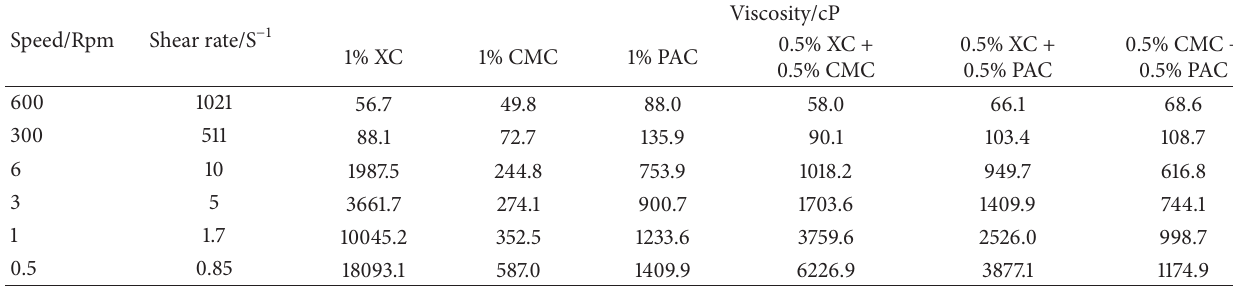
Table 1: The viscosity under different rotational speed.